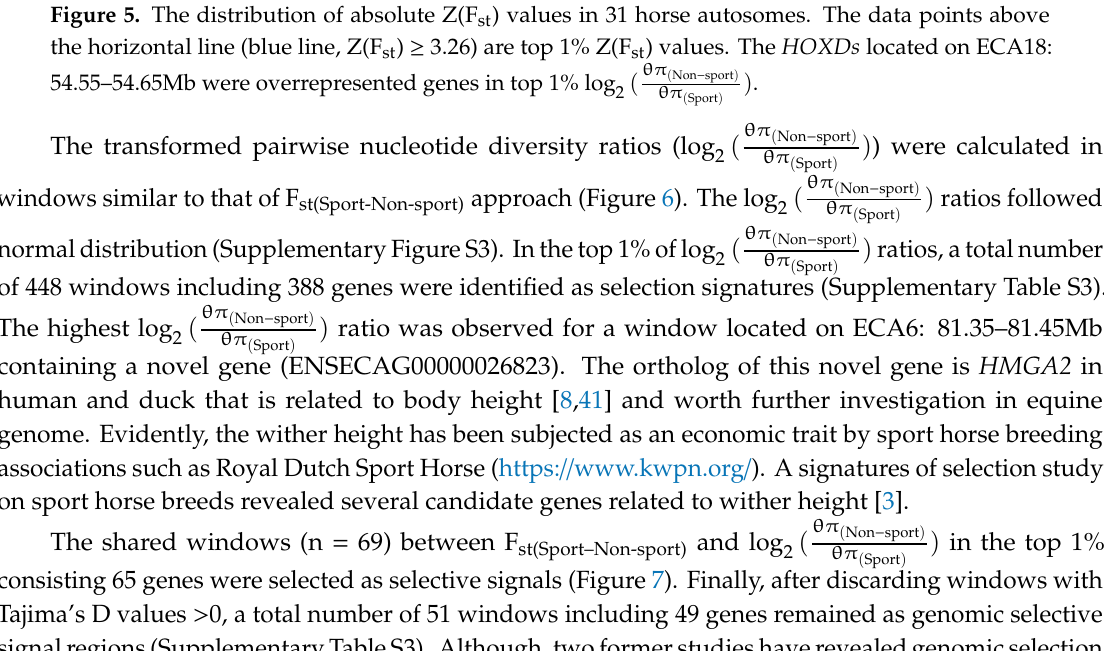
θπ ( Non − sport ) ( ) θπ (Non−sport) θπ ( Sport ) 2 ) . θπ (Sport)